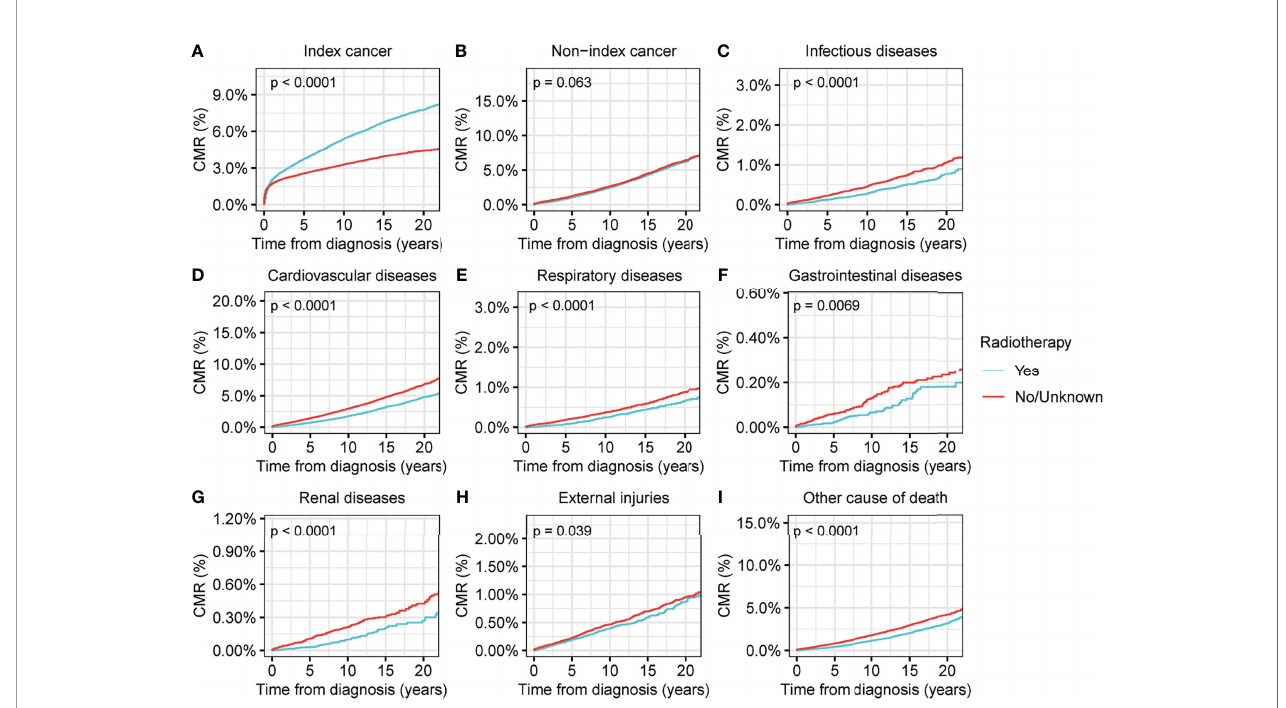
FIGURE 5 | Cumulative mortality rate (CMR) among patients with thyroid cancer by radiotherapy. (A) CMR from index cancer among patients with thyroid cancer by radiotherapy. (B) CMR from non-index cancer among patients with thyroid cancer by radiotherapy. (C) CMR from infectious diseases among patients with thyroid cancer by radiotherapy. (D) CMR from cardiovascular diseases among patients with thyroid cancer by radiotherapy. (E) CMR from respiratory diseases among patients with thyroid cancer by radiotherapy. (F) CMR from gastrointestinal diseases among patients with thyroid cancer by radiotherapy. (G) CMR from renal diseases among patients with thyroid cancer by surgery. (H) CMR from external injuries among patients with thyroid cancer by radiotherapy. (I) CMR from other non- cancer causes among patients with thyroid cancer by